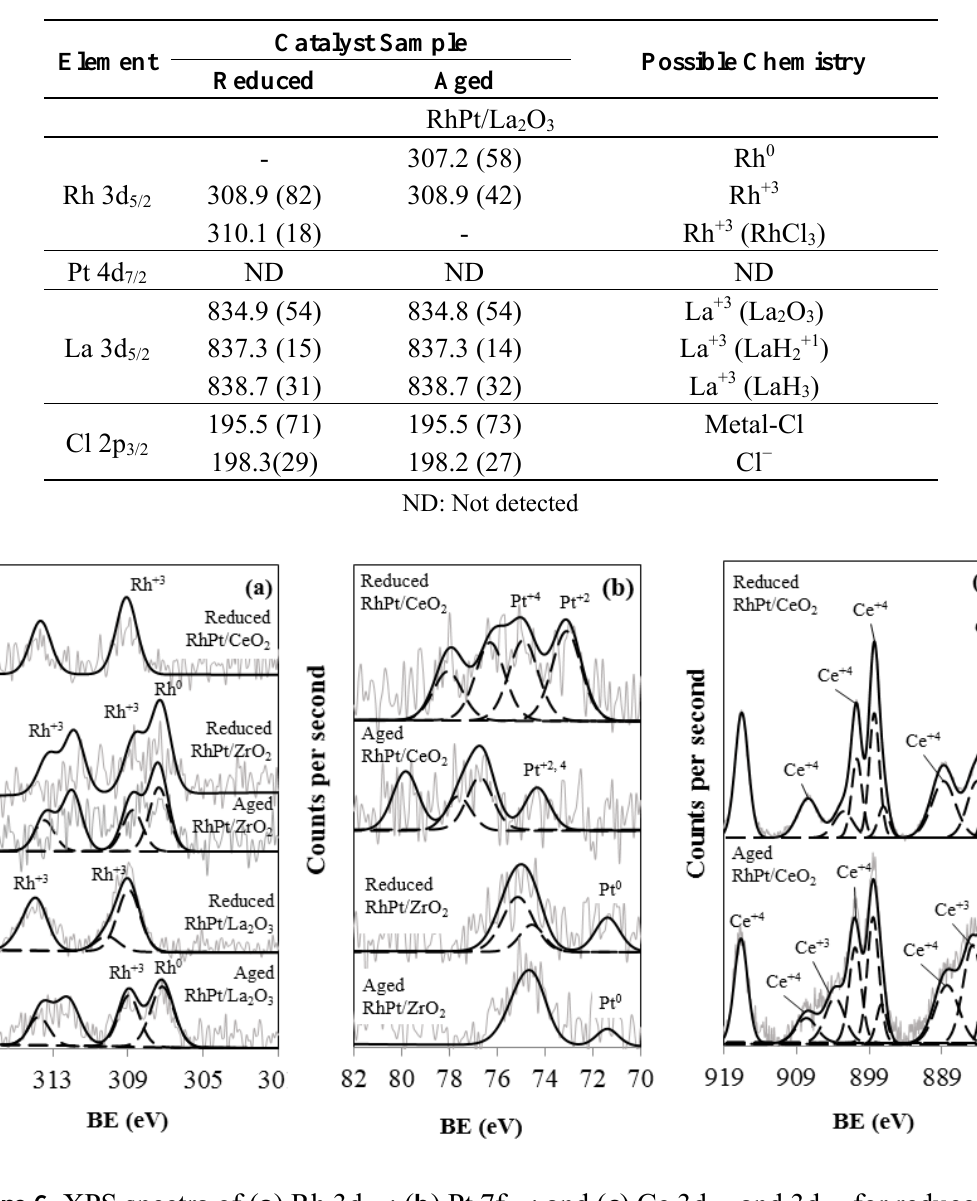
Figure 6. XPS spectra of ( a ) Rh 3d 5/2 ; ( b ) Pt 7f 7/2 ; and ( c ) Ce 3d 3/2 and 3d 5/2 for reduced and aged